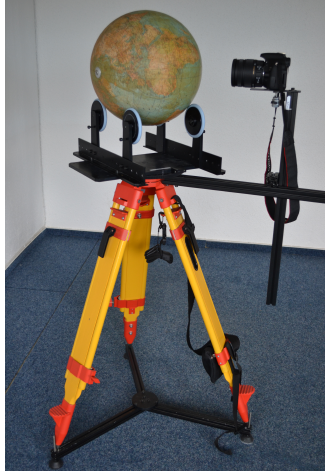
Figure 1. Device for digitizing globes Before digitization, the globe sphere has to be removed from its pedestal. The removal of the sphere is carried out by qualified employees of the collection. The globe is then settled into the device with its connecting line of North and South Pole lying in the horizontal axis, and North Pole lying on the right side from the view of camera. The placement of digital camera is also im- portant. The camera should be placed at an appropriate distance from the surface of the globe, and the optical axis of the camera should point to the center of the globe and be perpendicular to